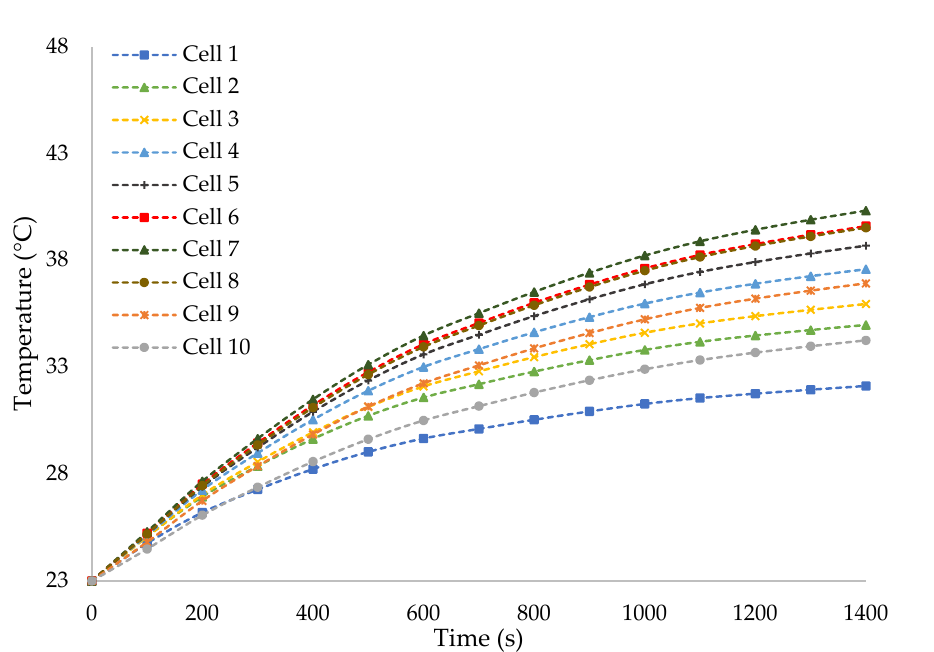
Figure 8. Temperature curves of all the LiCs in the module with inlet air velocity of V = 5 m/s.